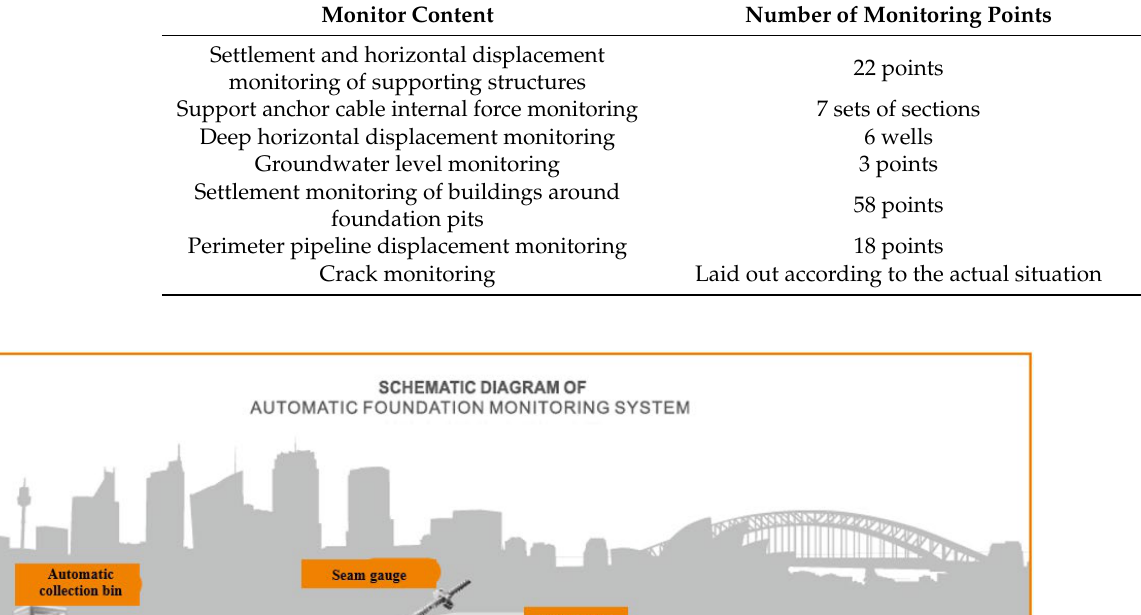
Table 3. Summary of monitoring points.